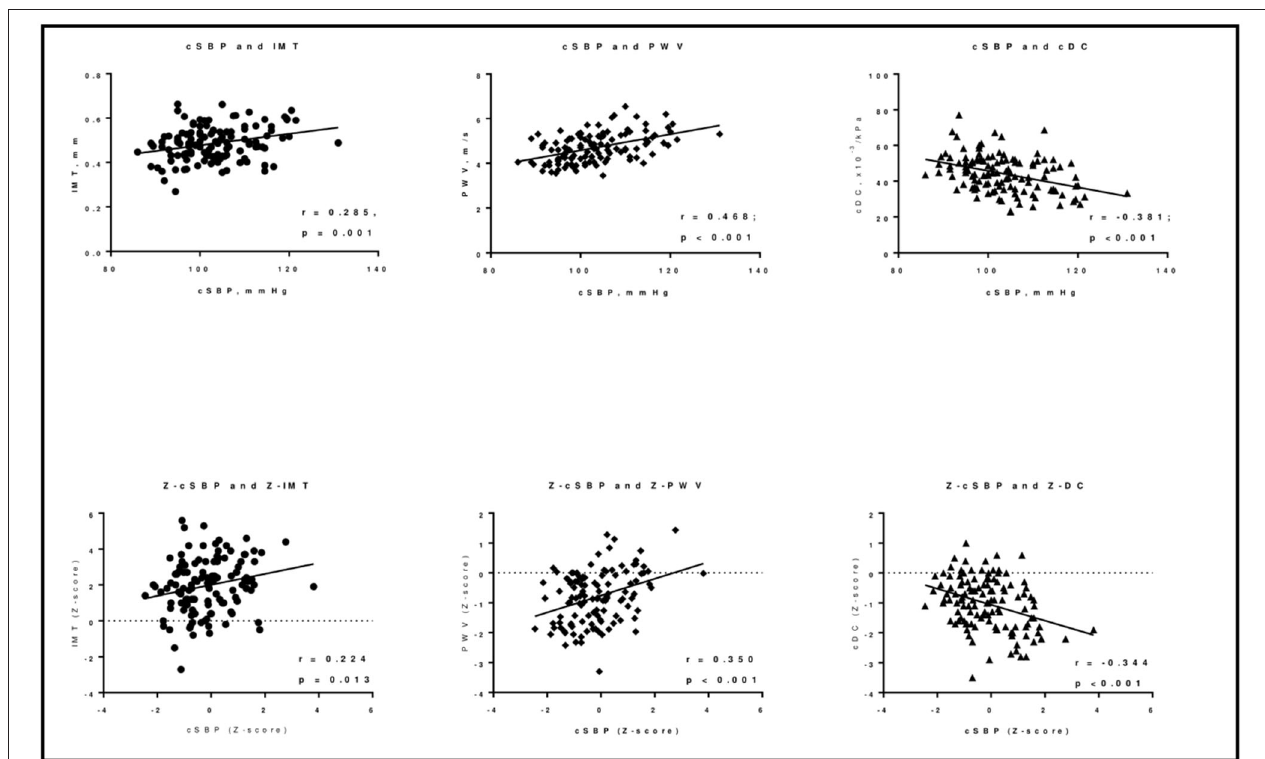
FIGURE 2 | Correlations between cSBP and the indices of early vascular damage in T1D children and adolescents. cDC, carotid distensibility coefficient; IMT, carotid Intima-Media Thickness; cSBP, central Systolic Blood Pressure; PWV, pulse wave velocity. *z- score for sex and height.